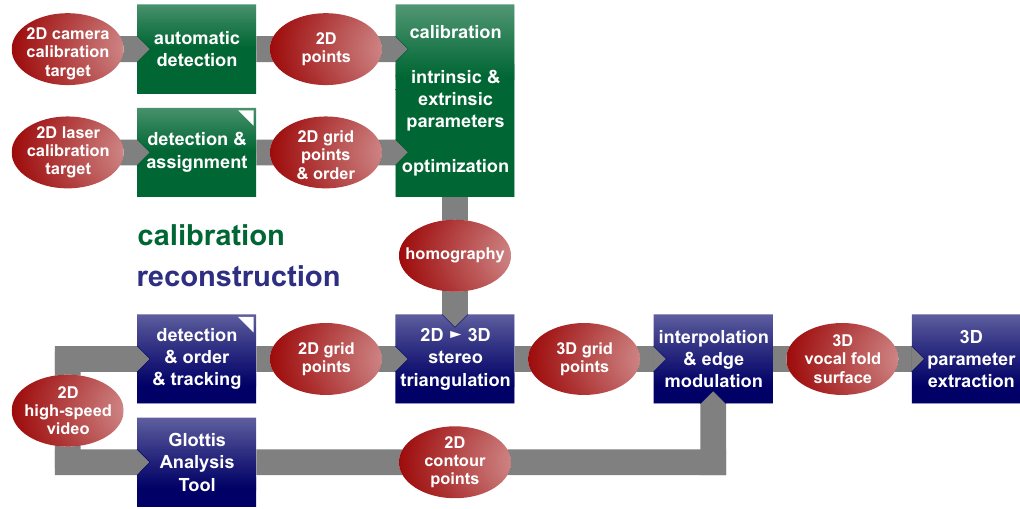
Figure 7. Flowchart of the calibration and reconstruction process. White corners indicate new processing